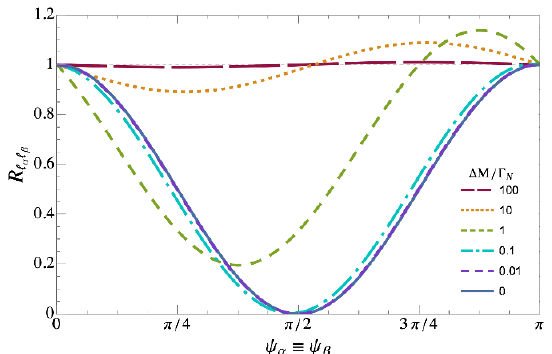
Figure 1 . The ratio R ‘ , as generically arising from the comparison of the LNC and LNV widths (cid:11) ‘ (cid:12) of any given semileptonic meson decay; R ‘ is depicted as a function of a common CP violating (cid:11) ‘ (cid:12) phase, (cid:11) = (cid:12) . Several regimes of (cid:1) M= (cid:0) N illustrate how the conditions of eq. (3.1) are crucial to observe maximal interference